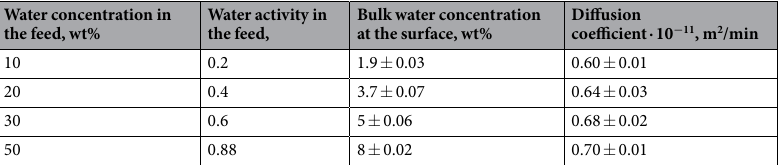
Water concentration in the feed, wt%